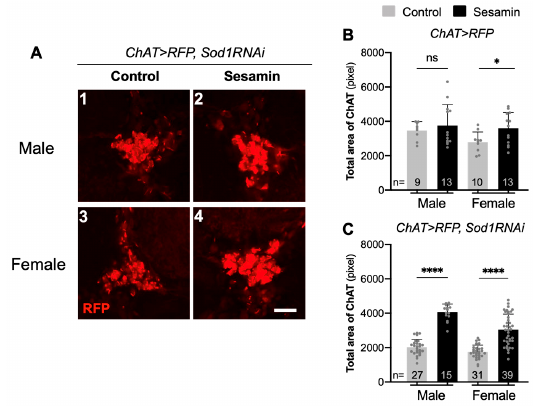
Figure 4. Suppression effects of sesamin on the oxidative stress-induced reduction of areas occupied by cholinergic neurons in adult brains harboring cholinergic neuron-specific depletion of Sod1 in adult brain. ( A ) In cholinergic neurons labelled in red by RFP expression, the neuron-specific deple- tion of Sod1 mRNA was carried out ( ChAT > RFP, Sod1RNAi ). Only a basal level expression of ChAT > RFP was observed in clusters of cholinergic neurons in male ( A1 ) and female brains ( A3 ) from flies fed on the control diet, while feeding of the diet with sesamin at 2 mg/mL enhanced the RFP fluo- rescence in both male ( A2 ) and female brains ( A4 ). ( B , C ) Total area occupied by the cholinergic neurons in brain ( ChAT > RFP ) ( B ), or in brains harboring cholinergic neuron-specific ROS accumu- lation due to the Sod1 depletion ChAT > RFP, Sod1RNAi ) ( C ) From adults (n >= 9 each). Brains were prepared from the male or female flies fed on a diet either with 0.5% DMSO only (control), or with sesamin at 2 mg/mL in 0.5% DMSO (sesamin) for 7 days. Scale bar represents 10 μ m. Student’s t - test, ns not significant, * p < 0.05, **** p < 0.0001.